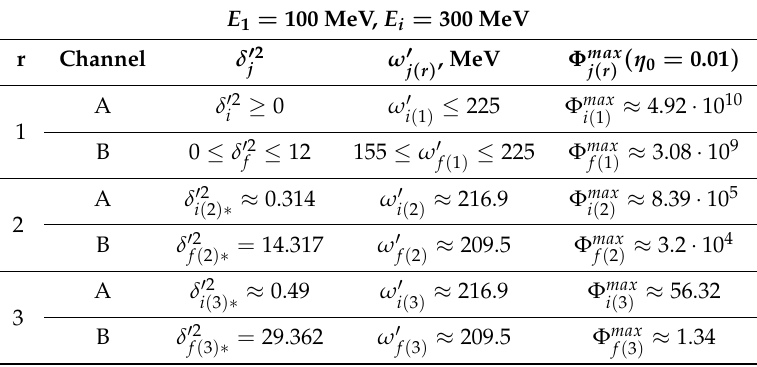
Table 1. The magnitudes of the differential cross-sections ( Φ max δ (cid:48) 2 , j = i , f (30) for channels A and B for the r = 1, 2, and 3 resonances when E 1 = 100 j